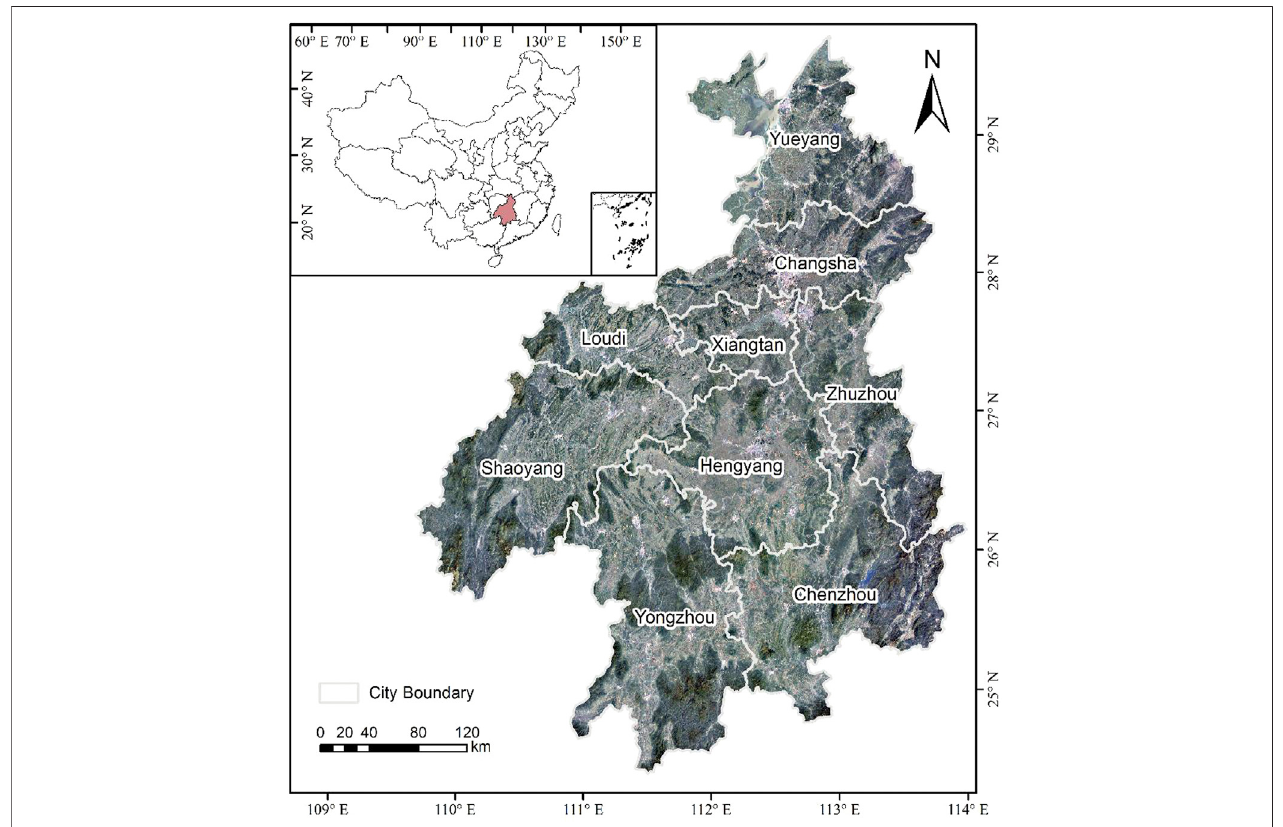
FIGURE 1 | Study area: Urban agglomeration of Xiangjiang river